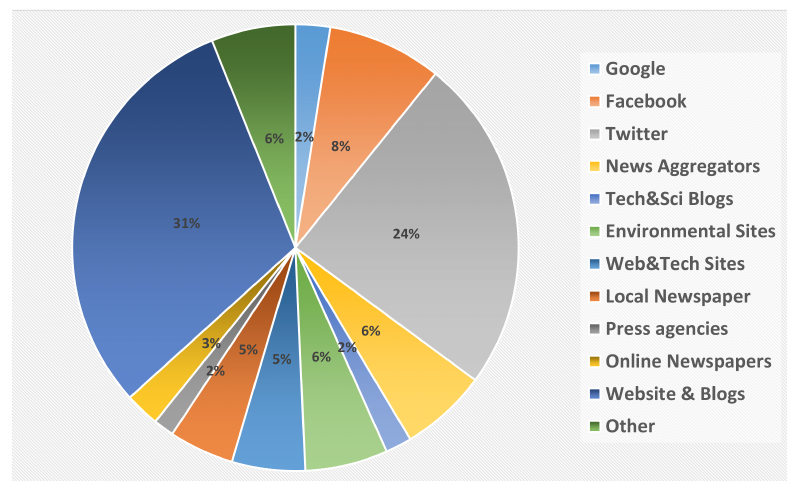
Figure 6. Media impact of ARGO Sentinel in ten days after its